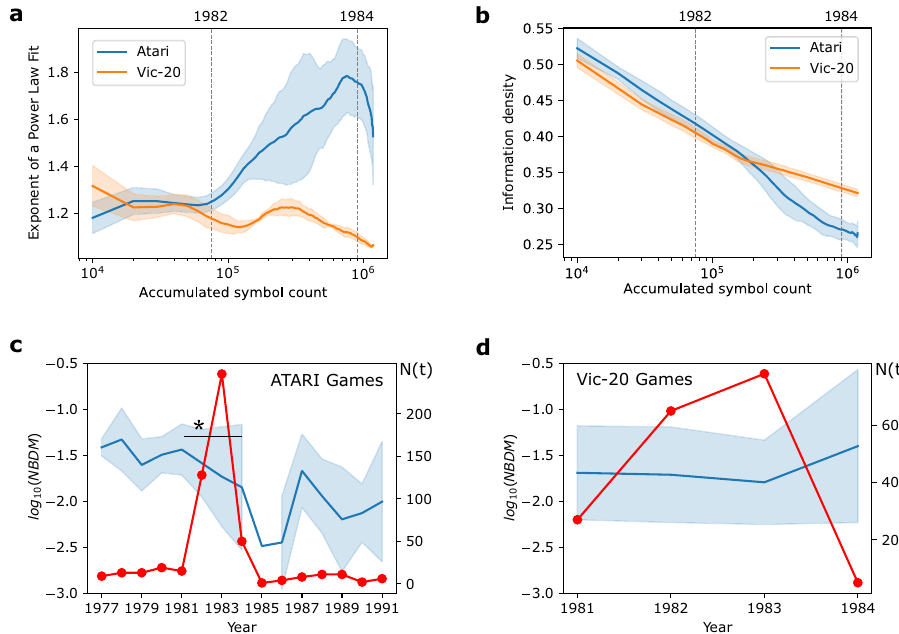
Fig. 5 Evolution of multi-scale diversity during the 1983 crash of video games. a Zipf's law exponent evolution for a given accumulated number of machine instructions in Atari 2600 (blue) and Commodore Vic-20 (orange). Solid line represents the average exponent of 25 replicate sub-samplings and shaded region encompasses 1 standard deviation of this distribution. b Decay of information density for the accumulated number of symbols n ( t ) in Atari 2600 (blue) and Commodore Vic-20 (orange). Solid line represents the average information density of 25 replicates within-year orderings and the shaded region encompasses one standard deviation of the distribution. As a guide, vertical dashed lines mark the dates before (1982) and after (1984) the crash of Atari video games in panels a and b . The evolution of log-transformed size-normalized structural complexity (NBDM) in c Atari 2600 and d Commodore Vic-20 video games. Red line shows the cultural product diversity N ( t ) in each domain for c and d . Asterisk-marked regions indicate statistically signi fi cant drops in complexity (see Supplementary